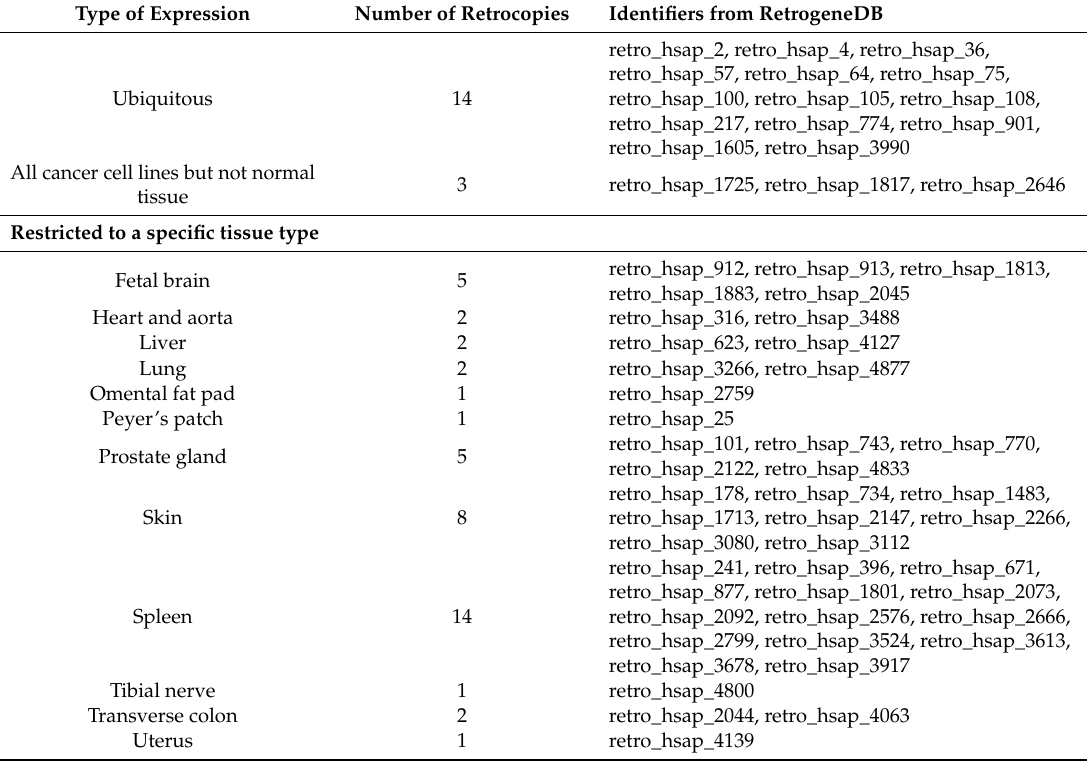
Table 1. Retrocopies with a ubiquitous and tissue specific